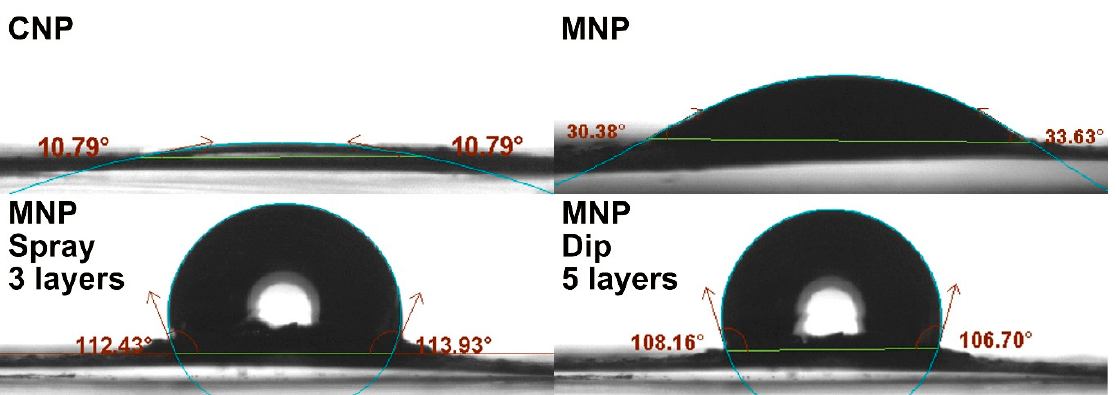
Figure 5. Contact angle measurements of CNP, MNP, spray-coated MNP with 3 layers of 1.0 wt.% solution, and dip-coated MNP with 5 layers of 1.0 wt.% solution.